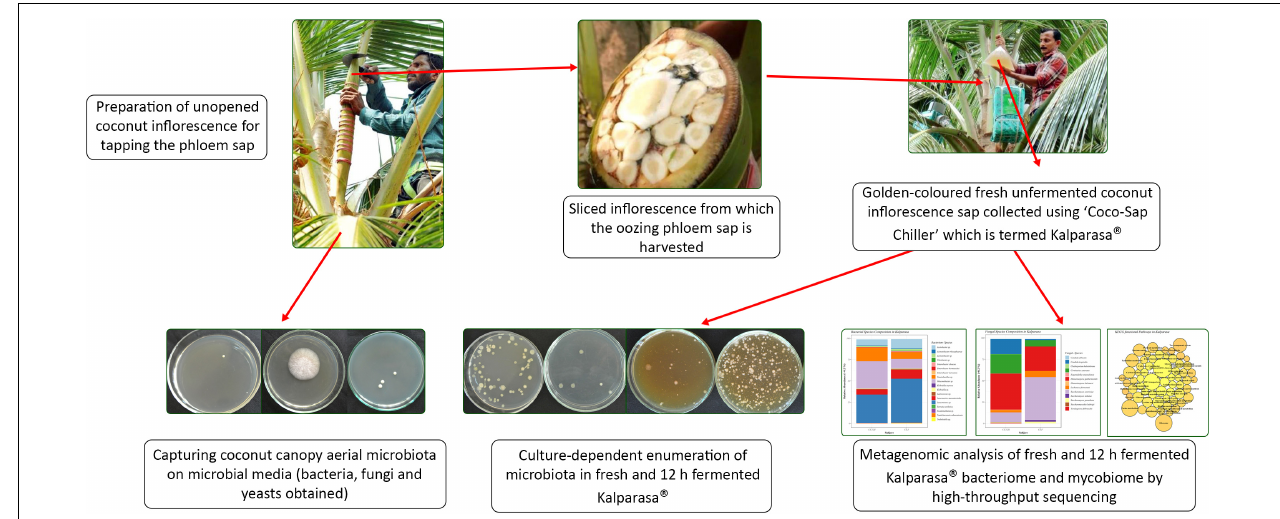
FIGURE 11 | A snapshot graphics capturing the work presented on Kalparasa microbiome